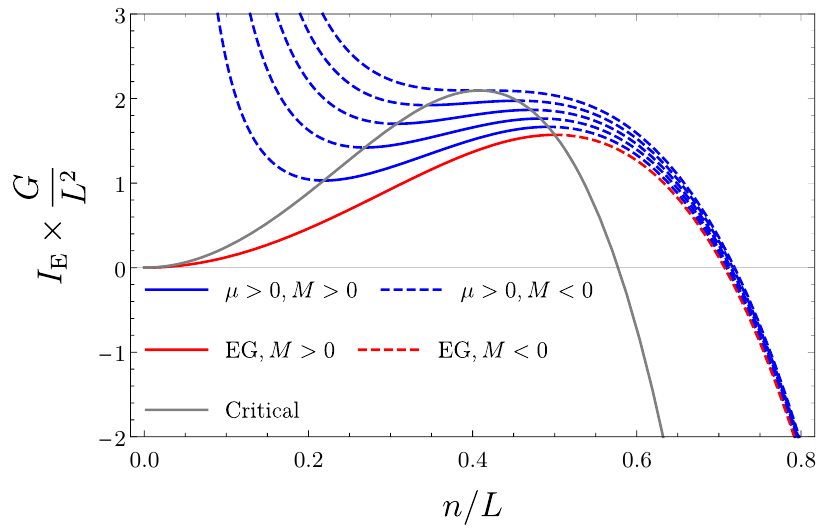
Figure 2 . Free energy of the NUT solution with S 2 base. In red we show the Einstein gravity result and in blue the ECG ones for (cid:22) = 8 = 270 ; 16 = 270 ; 24 = 270 ; 32 = 270 ; 4 = 27. The mass M is proportional to the slope of each curve and solid lines represent M > 0 while dashed lines represent M < 0. For ECG only the solutions with M > 0 exist. We also plot the free energy of the special critical solution (2.30), whose metric function is given in (2.23). Remarkably, this curve is the envelope of the free energies with M >